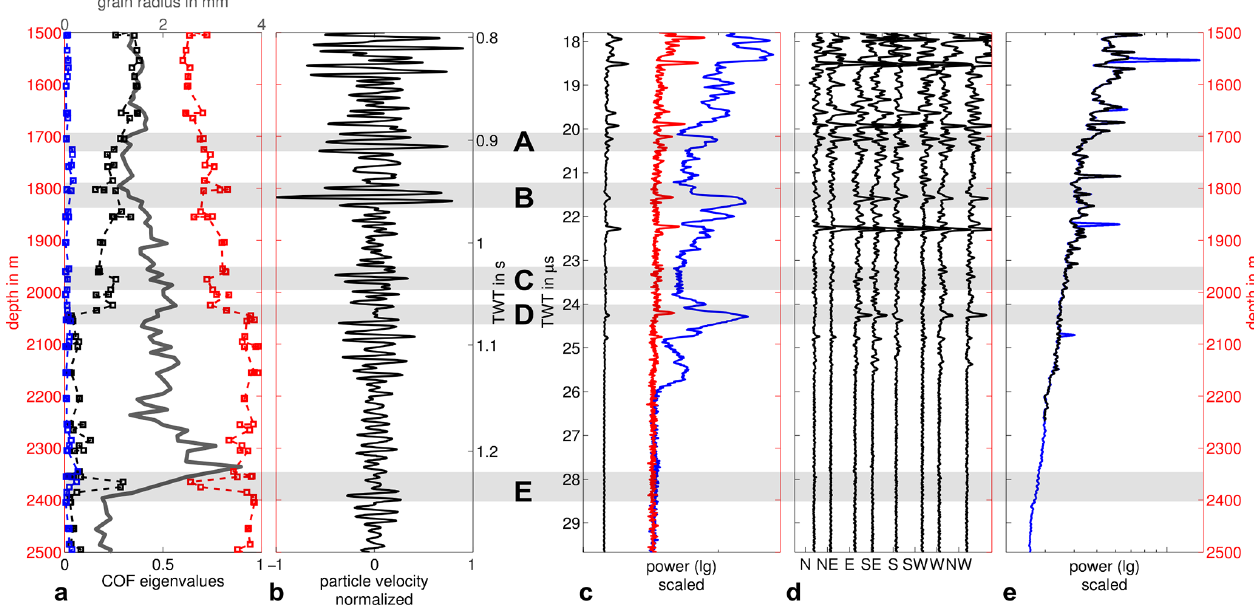
Figure 8. Comparison of (a) ice-core COF eigenvalues and grain radius r (diameter d = 2 r ), (b) with a stacked seismic trace of sur- vey 20120537, ( c , d ) radar data and (e) modelled (synthetic) radar data. (c) shows the radar traces closest to the EDML drill location from survey 022150 (600ns pulse) in blue and 023150 (60ns pulse) in red, together with a stack of all traces of survey 033042 (60ns pulse) in black. (d) shows stacked traces of survey 033042 for different airplane headings, i.e. different polarizations (Fig. 1). (e) is a forward- modelled radar trace from DEP measurements with (blue) and without (black) conductivity peaks (Eisen et al., 2007). All figures are plotted over depth (red axis), with the two-way travel time on the seismic and radar traces additionally marked (black axis). The marked events A–E are discussed in the